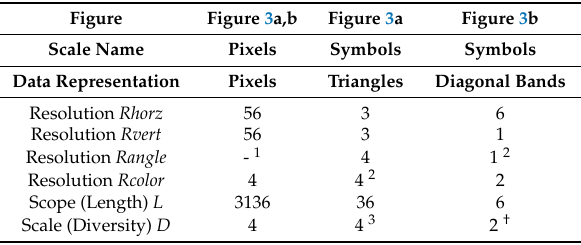
Table 2. Properties of each interpretation of 2D patterns shown in Figure